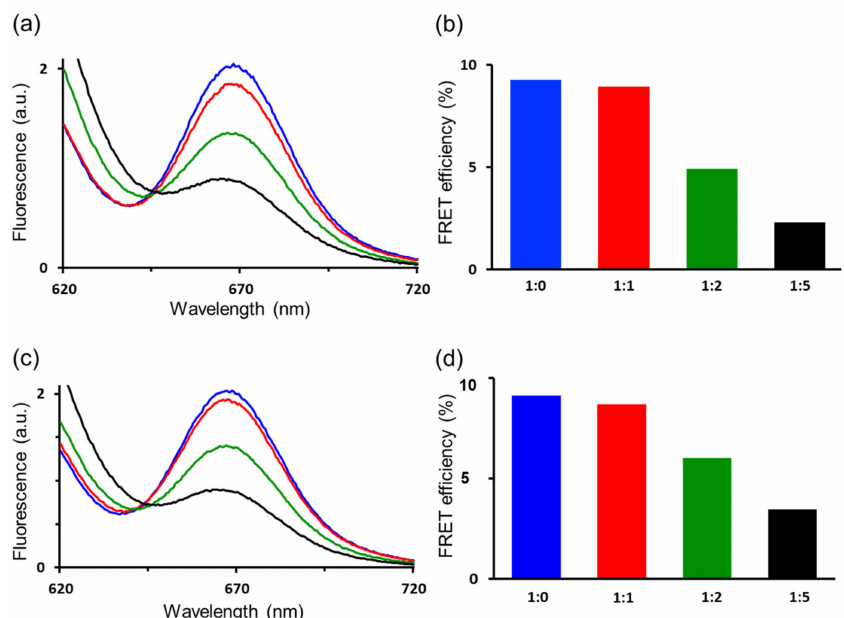
Figure 5. FRET verification of the possible effects of artificial linking of Ub units. The emis- sion spectra corresponding to FRET of ( a ) Alexa647-diUb-Cy3 and ( c ) Alexa647-diUb EA -Cy3. The FRET efficiency calculated from the corresponding FRET intensities of ( b ) Alexa647-diUb-Cy3 and ( d ) Alexa647-diUb EA -Cy3. The molar ratios of diUb derivatives to E2-25K were 1:0 (black), 1:1 (red), 1:2 (green), and 1:5